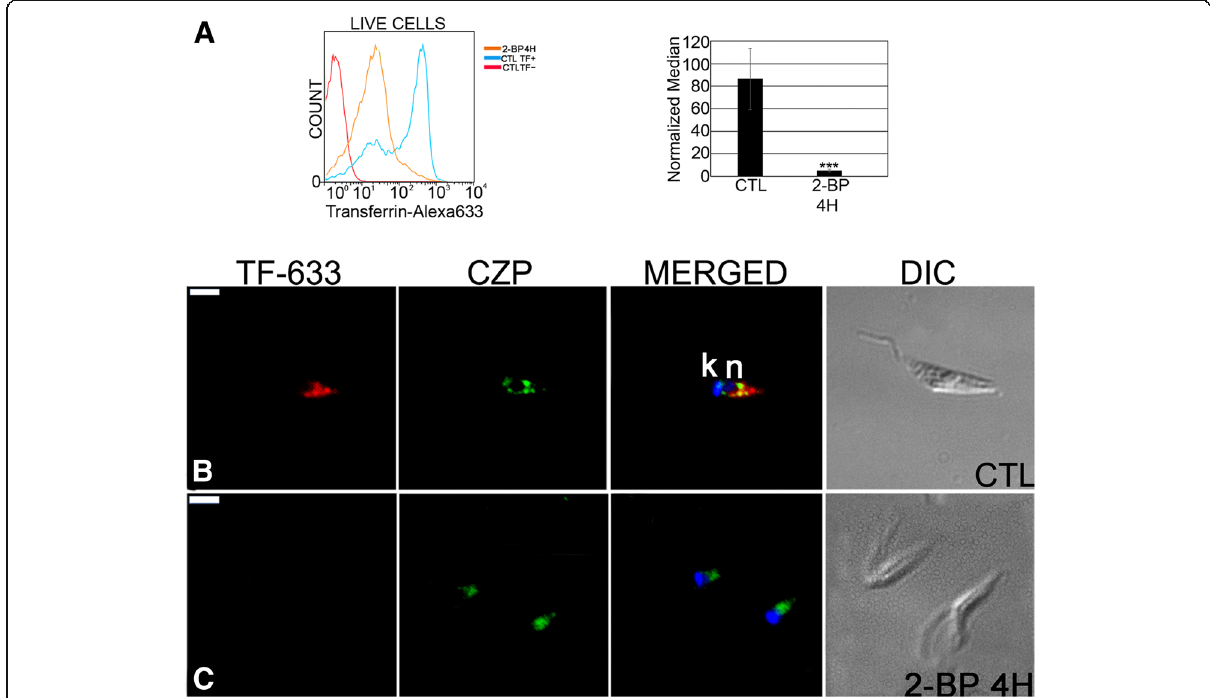
Fig. 5 Transferrin-AlexaFluor 633 endocytosis is altered in Trypanosoma cruzi epimastigotes by 2-BP treatment. a Flow cytometry analysis showing that transferrin internalization was inhibited after 4 h of treatment with 2-BP. ***: p < 0.001. b Control cell: co-localization of internalized transferrin (TF-633) with cruzipain (CZP) in reservosomes by fluorescence microscopy. c Parasites treated for 4 h with 2-BP showing no fluorescence signal for transferrin. n: nucleus; k: kinetoplast. Bars = 5 μ